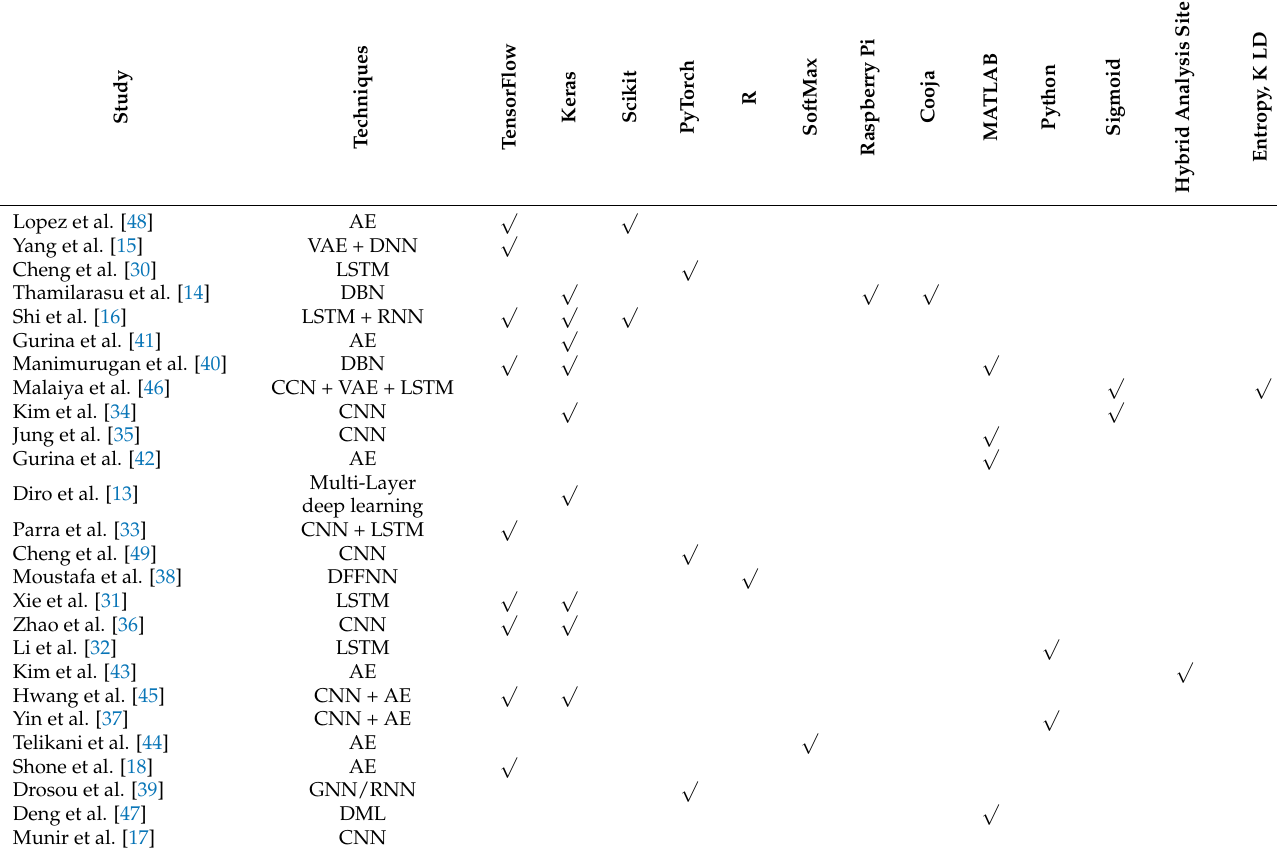
Table 5. Tools and environments applied by the studied work.